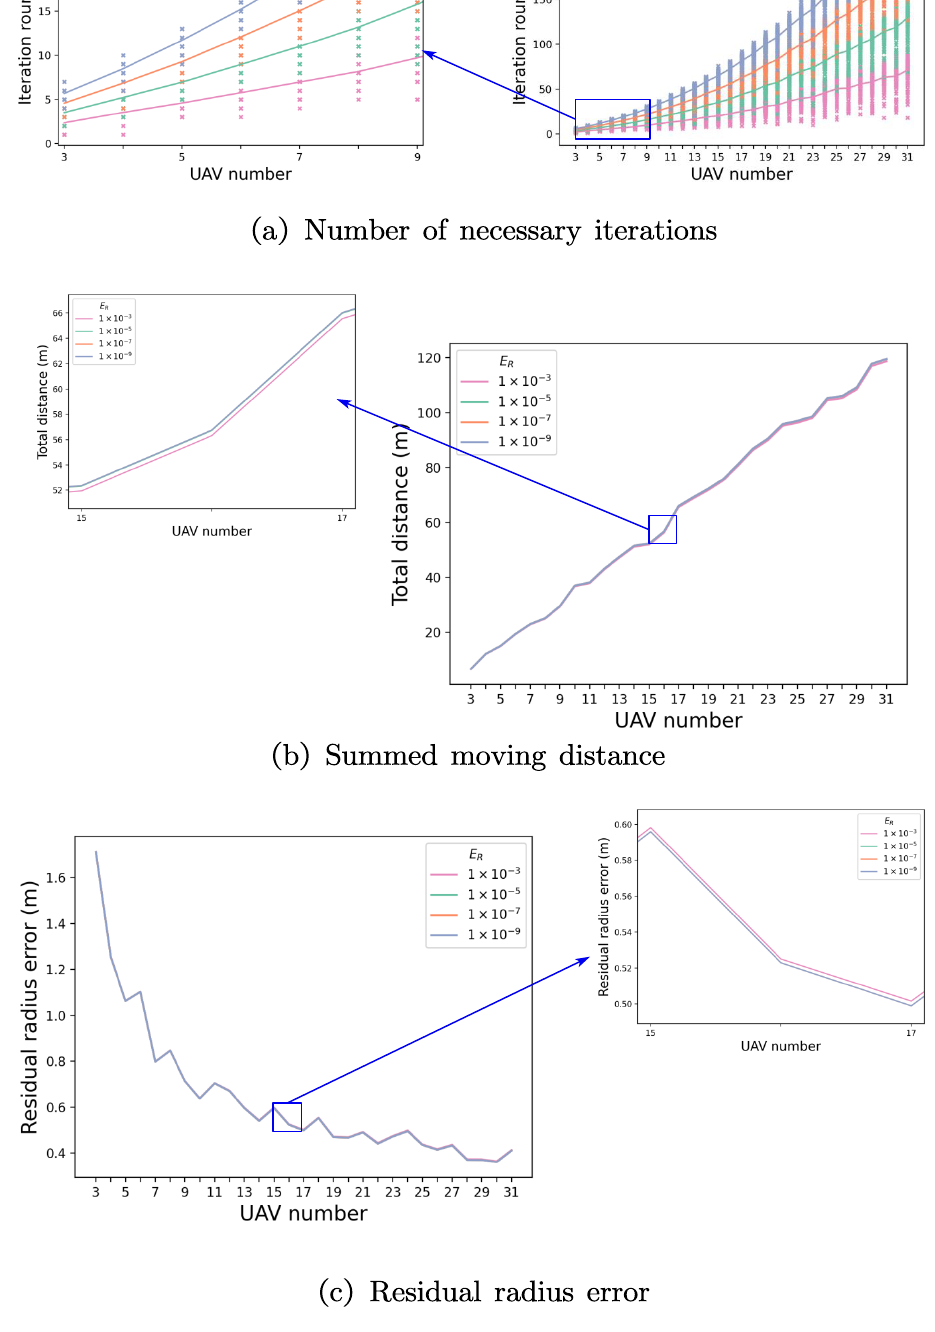
Figure 6. The performance of the